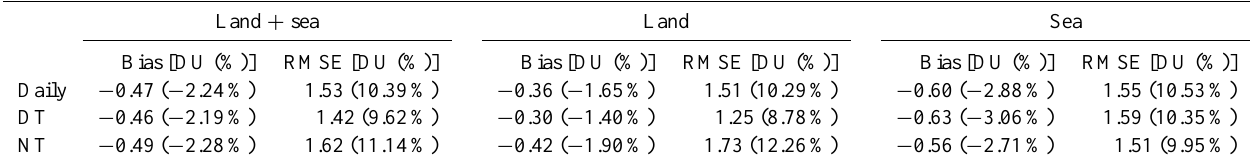
Table 5. Same as Table 4 but for surface–3km TOC